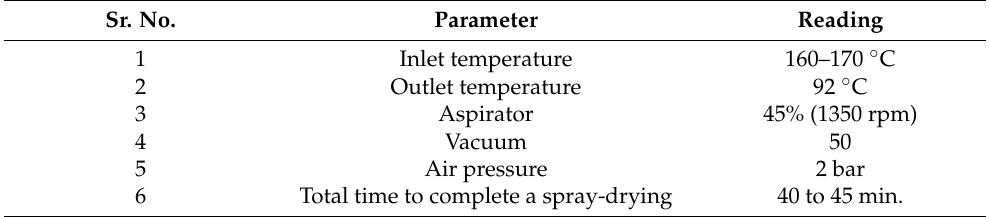
Table 2. Parameters of the spray